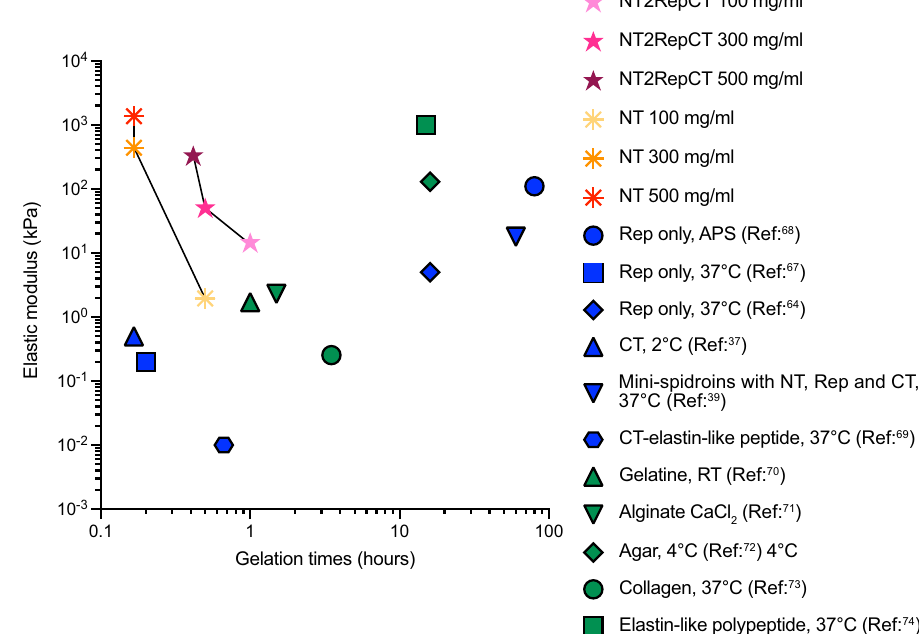
Fig.7|Hydrogelproperties. Gelationtimeandstoragemodulusofhydrogelsfrom the present study in comparison to other spidroin-based hydrogels and selected naturalhydrogels.Literaturereferencesaregiventogetherwithanindicationofthe